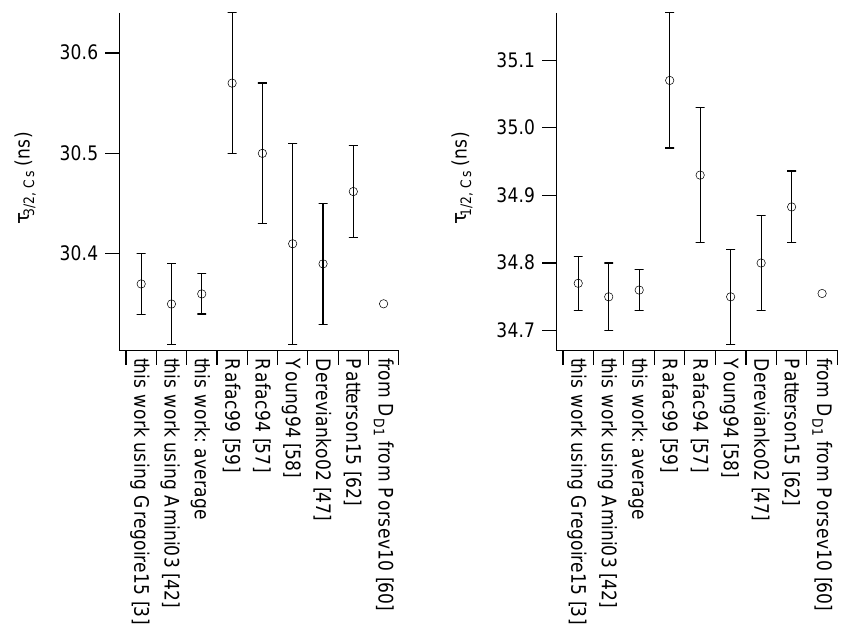
Figure 4. Comparisons of Cs principal transition lifetimes inferred from polarizability measurements [3,42] and theoretical α r ,Cs ( 0 ) [47], direct measurements [57–59], semi-empirical values [47], and a combination of Porsev et al.’s calculated | D D 1 | [60] and R